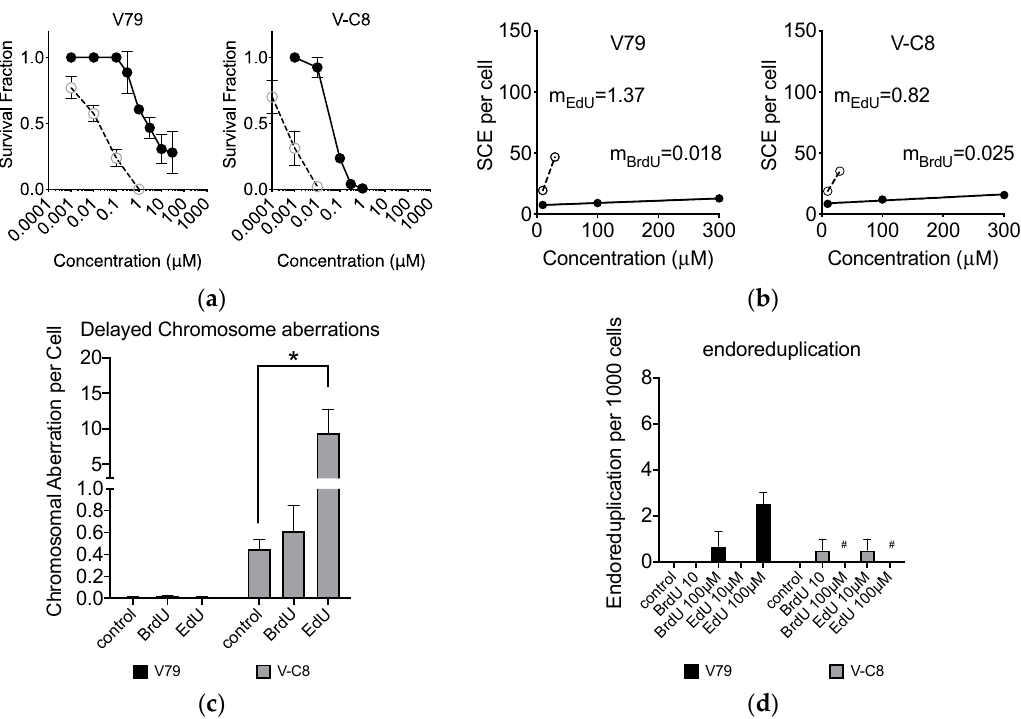
Figure 8. BrdU and EdU e ff ects for Chinese hamster lung origin V79 cells and their BRCA2-deficient V-C8 cells. ( a ) Cytotoxicity with BrdU or EdU treatment; ( b ) SCE formation with BrdU or EdU treatment; ( c ) delayed e ff ect for genomic damages after 10 µ M BrdU or EdU; ( d ) endoreduplication formation after BrdU or EdU treatment. Closed circles indicate BrdU treatments and open circles indicate EdU treatments. Error bars represent the standard error of the mean of three independent experiments. One-way ANOVA, Dunnett’s Multiple Comparison Test was performed to provide p -values. * indicates statistically significant di ff erences. n.s. stands for not significant ( p > 0.05). # indicates no data available due to high toxicity.